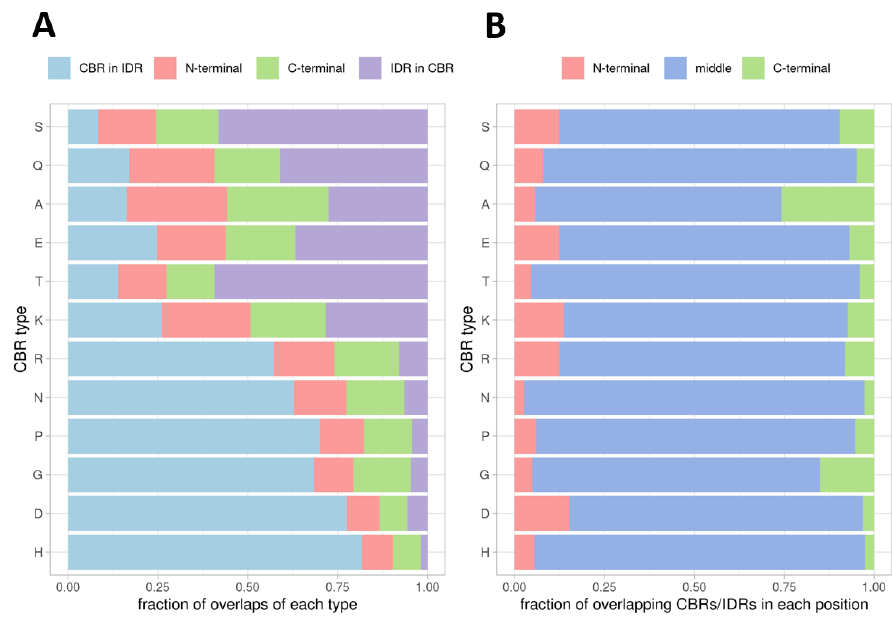
Figure 4. Position of CBR overlaps with IDRs. ( A ) Distribution of the positions of the overlaps of CBRs to IDRs (predicted with IUPred2A) relative to the IDR: IDR (included) in CBR, CBR (included) in IDR, CBR overlaps only the N-terminal of the IDR, CBR overlaps only the C-terminal of the IDR. ( B ) Distribution of the positions of overlaps of CBRs to IDRs by type relative to the protein: N-terminal 10 amino acids, C-terminal 10 amino acids, or else middle. CBR types have been arranged from longest (top) to shortest (bottom) median length (Table 1).